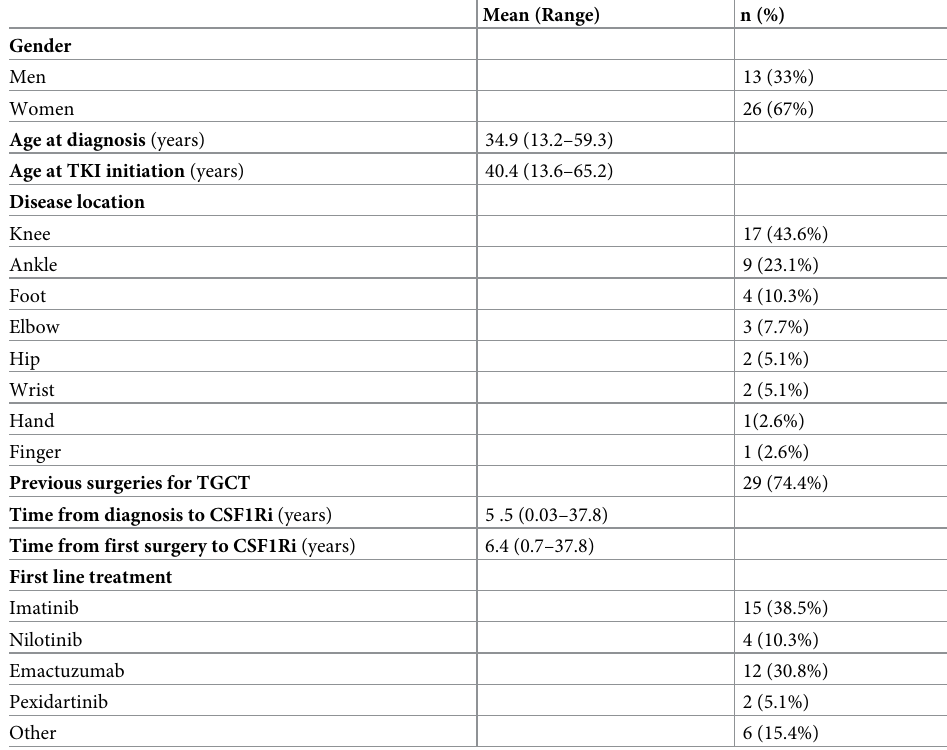
Table 1. Characteristics of patients treated with CSF1R